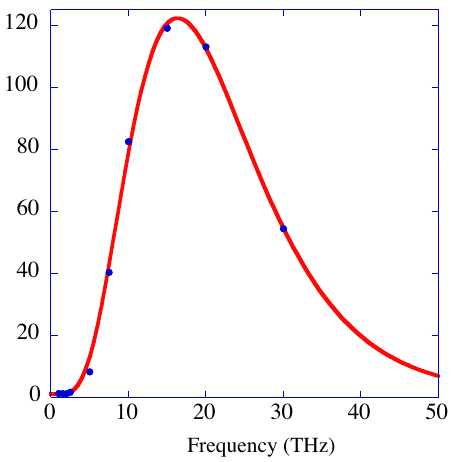
FIG. 7. Simulated PCI amplitude gain as a function of the modulation frequency: dots are results of simu- lation; the red curve is a fit. As expected from analytical studies, the PCI is a broadband microbunching instability with Δ f=f ∼ 1 , but it is suppressed both at very low and very high frequencies.